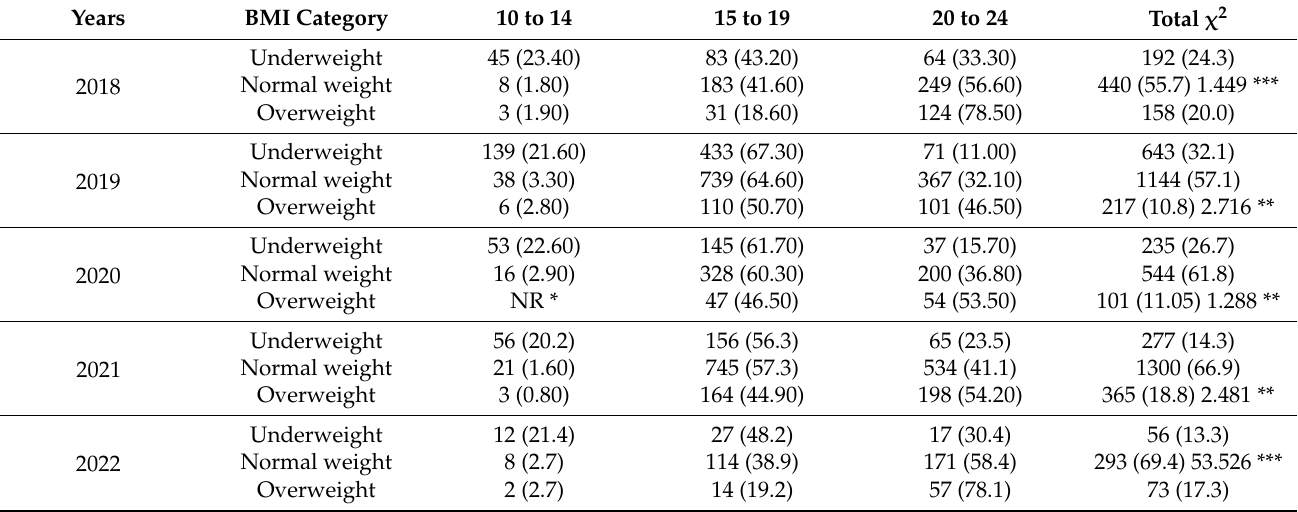
Table 3. Year-wise distribution of body mass index by different age